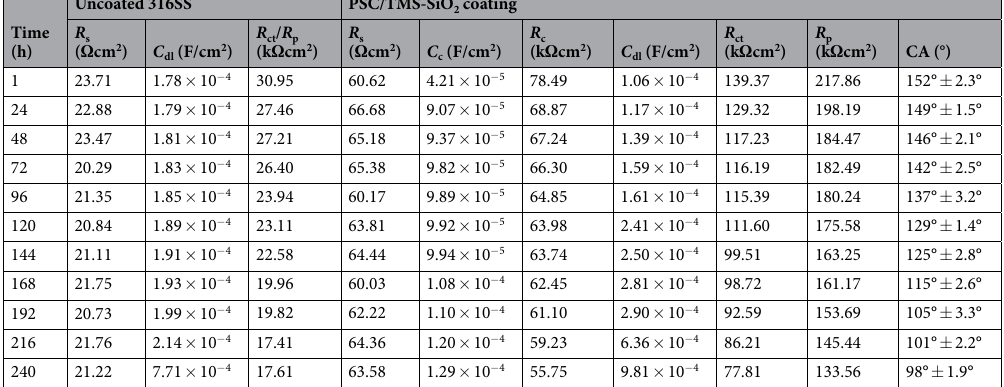
the subsequent TMS-SiO 2 layers which hinders the diffusion of aggressive species. At exposure time 120–192 h, there is a gradual increase in C c values due to the dominant hydrophilic effect of PSC layers. Finally, at 216–240 h of immersion an accelerated diffusion of corrosive species was observed supported by the increase in C c values. In spite of this, the oxide layer on the SS surface in the presence of PANI matrix tries to maintain the anti-corrosion ability of the coating. The R ct values of PSC/TMS-SiO 2 coating gradually decrease with the immersion time, but the coating maintains the passivity of the SS surface as compared to uncoated samples. To further explain the protection mechanism of the coating, polarization resistance ( R p ) was used and Fig. 8c shows the contrast between the R p of the uncoated SS and PSC/TMS-SiO 2 coating. For uncoated SS, the R p values gradually decrease from 30.95 to 17.61 k Ω cm 2 and the direct contact of aerated solution with SS surface results in the formation of an oxide layer. This layer would slowly damage during 240 h of exposure in a 3.5% NaCl solution (Table 4). In contrast, the R p value of the PSC/TMS-SiO 2 coating remains high after 1 h of immersion due to water repelling ability of the coating. After 24 h the slight decrease in the R p value was associated with the permeation of aggressive chloride ions that affect the water repelling property of the coating. This phenomenon was attributed to the slow loss of the surface hydrophobicity and uptake of aerated corrosive solution. In spite of this, the R p values of the PSC/TMS-SiO 2 coating were higher than the uncoated samples throughout the exposure time. At 48–96 h of immersion, the R p values stabilized within the range of 117.23–115.39 k Ω cm 2 followed by a gradual decrease in R p . The stability is associated with the synergistic barrier ability of electro-active PSC and subsequent TMS-SiO 2 layers. Further increase in exposure time, i.e., 144–240 h results a little decease in R p values, however, the transformation between different PANI oxidation states and its redox catalytic behavior was activated. As a result, PANI would attain a positive potential in emeraldine state which passivates the SS surface and hence sta- bilized the corrosion process 71 . In addition, the diffused oxygen would reached the coating/metal interface which result in the formation of metal oxide layer (supported by XPS data) and maintains the anti-corrosion ability during prolonged exposure 59 . However, the high R p values and a gradual decrease with immersion time suggest that the coating prevents the sudden breakdown of SS surface and maintains the corrosion resistance for longer time. Moreover, the change in CAs of PSC/TMS-SiO 2 coating surface with immersion time in 3.5% NaCl solution was measured and summarized in (Table 4). Initially, the coating maintains the super-hydrophobicity even being exposed to chloride containing environment, but after 96 h of immersion the electrolyte trying to diffuse into the coating consequently affect the surface wettability of the coating. Therefore, the CA values decreases with increas- ing immersion time and reached to 98° ± 1.9° at 240 h of immersion. Importantly, the coating still maintains the hydrophobicity and stabilized the quick degradation of the coating during prolonged immersion and protects the underlying metal. The effect of long term immersion on morphology of coated and uncoated PSC/TMS-SiO 2 coating was fur- ther studied through visual screening. Fig. S7a and S7b show the digital images of the polished and coated 316SS before immersion in 3.5% NaCl. The Fig. S7c and S7d shows the red dotted line encircled area of diameter 1 cm is exposed to 3.5% NaCl for 240 h. It can be seen that severe pitting corrosion was initiated with the appearance of dots which can clearly be seen in the magnified microscopic image of polished SS surface (Fig. S7e). In contrast, the PSC/TMS-SiO 2 coating sacrifices itself during prolonged immersion time in saturated chloride media and cracks were originated, but there is no delamination and quick decrease in resistance was observed even after 240 h of immersion (supported by Fig. 8b). These microscopic images reveal that the coating significantly protects the underlying SS surface, even after 240 h of immersion by sacrificing itself and increases the lifespan of SS in corrosive media. From these observations we conclude that different mechanism involved in the prolonged corrosion protec- tion ability of the PSC/TMS-SiO 2 coating: (i) the super-hydrophobicity of the coating enhances the water repel- lent property, (ii) the good barrier ability of the coating was attributed to the combination of PSC and TMS-SiO 2 in a multilayer structure, (iii) PANI maintain its emraldine state with anodic passivation during the redox trans- formation and its presence at the coating/metal interface would result in the formation of oxide layer 64 . It is worthwhile to point out that the PSC/TMS-SiO 2 coating maintains its aesthetic appearance during prolonged exposure of 240 h and enhances the corrosion resistance of the SS (supported by electrochemical studies). These